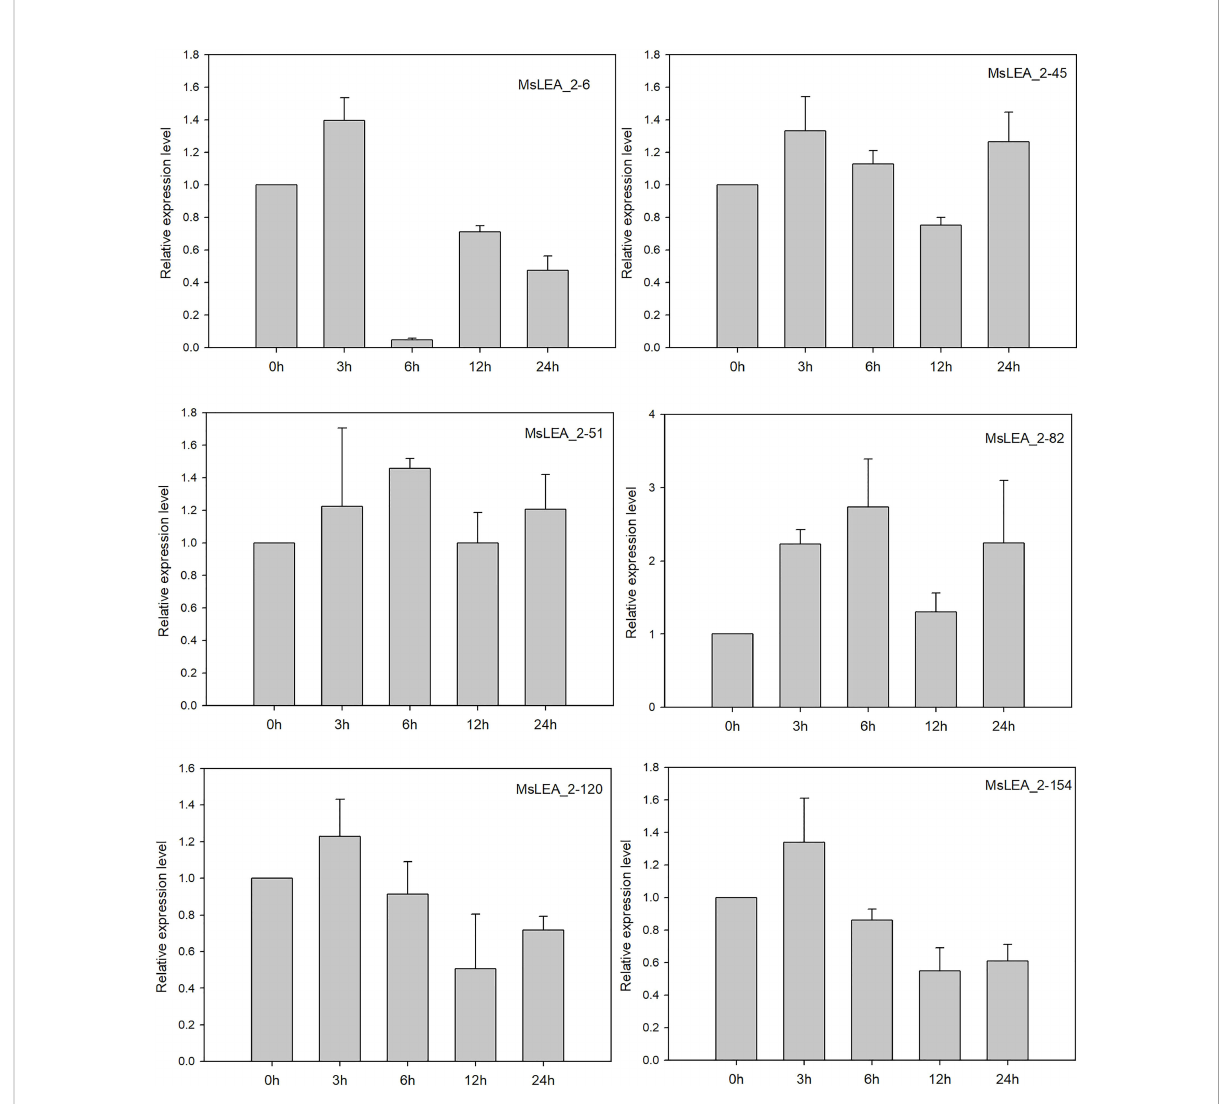
FIGURE 10 The relative expression levels of six MsLEA_2 genes under Al stress were analyzed by qRT-PCR. 14-days-old alfalfa seedlings were sampled after 0 h, 3 h, 6 h, 9 h, 12 h, and 24 h under 100 m M Al3+ treatment. The relative expression of six MsLEA_2 genes ( MsLEA_2-6 , MsLEA_2-45 , MsLEA_2-51 , MsLEA_2-82 , MsLEA_2-120 , MsLEA_2-154 ) were calculated using the 2 - △△ CT method with housekeeping gene MsEF-a as an endogenous